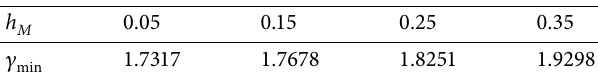
Table 1: Diferent performance c h � 0 . m